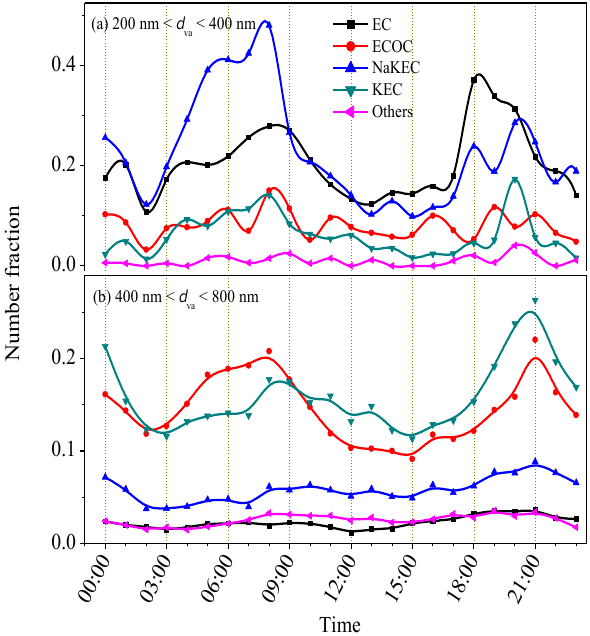
Figure 7. Diurnal variations in number fraction of each classified particle type: (a) G 200 − 400 : 200< d va <400nm and (b) G 400 − 800 : 400< d va <800nm.